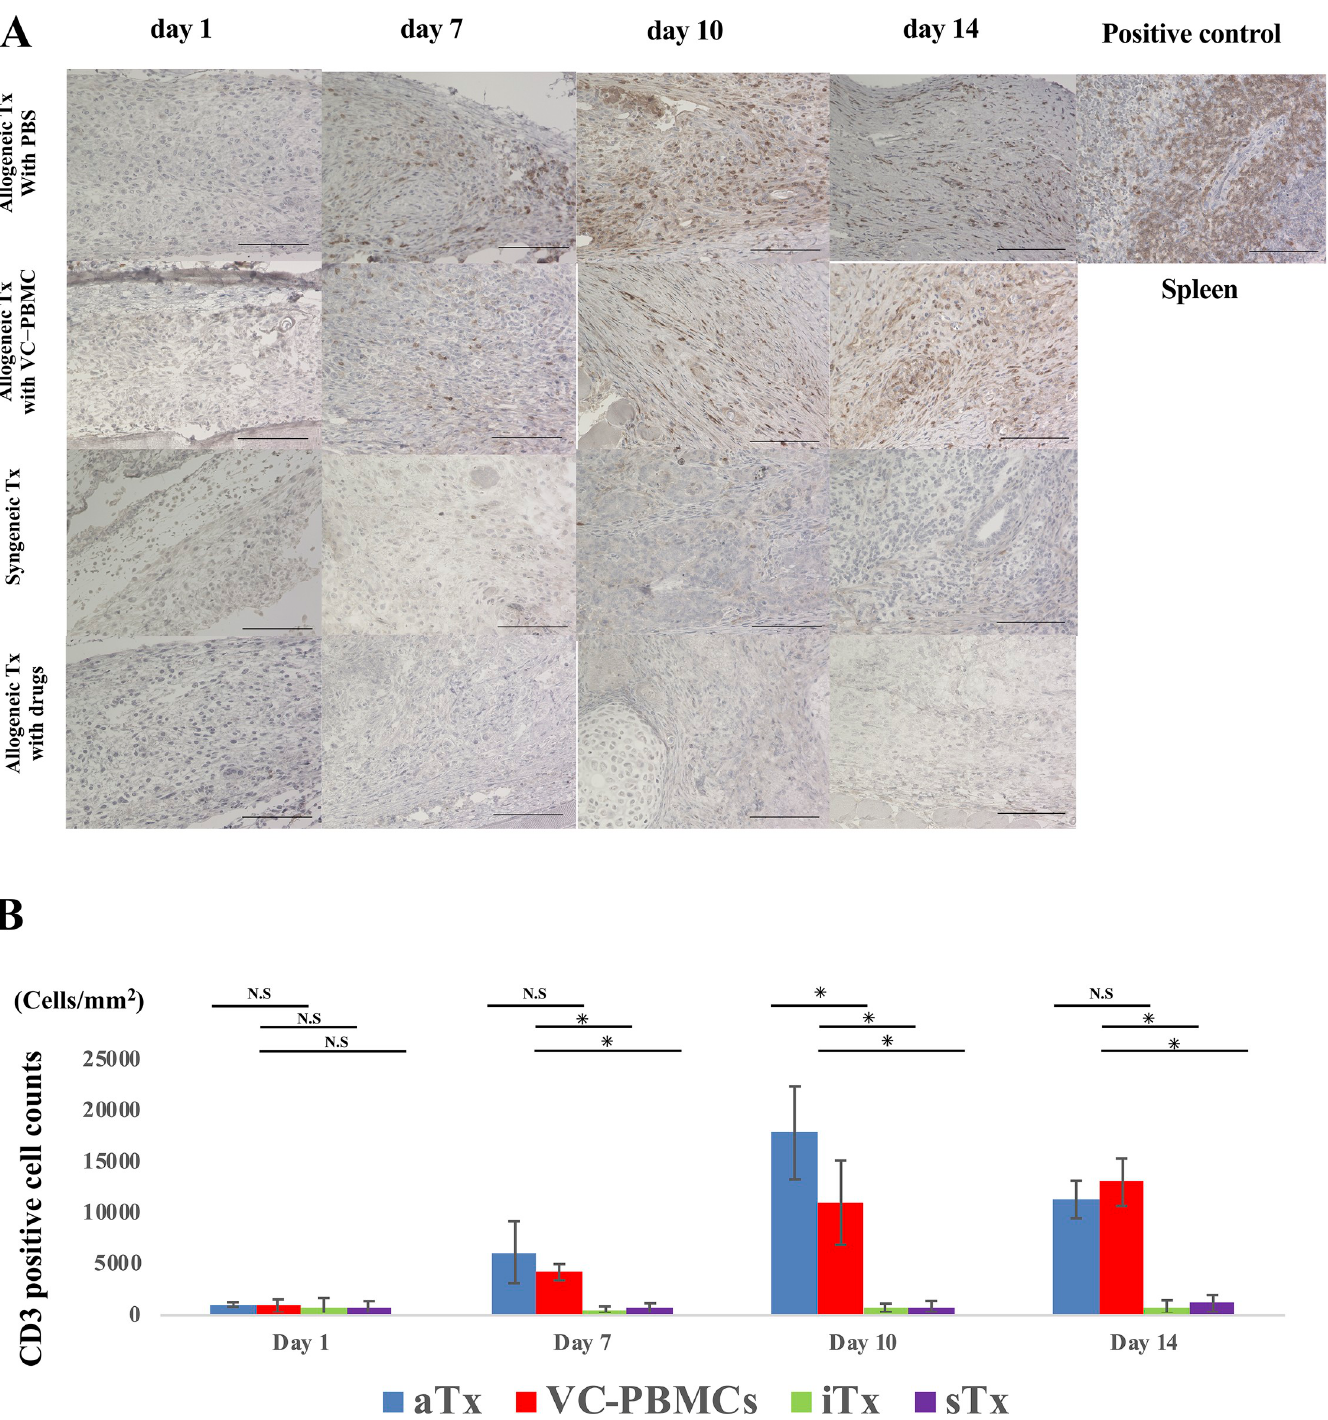
Fig 3. Infiltration of activated T cell lymphocytes into the grafts. A , CD3 + activated T lymphocytes into grafts at days 1, 7, 10, and 14, using spleen tissue as positive control. B , Comparison among groups of CD3 + cell counts. Scale bar, 100 μ m. � , P < 0.05; N.S., not significant.